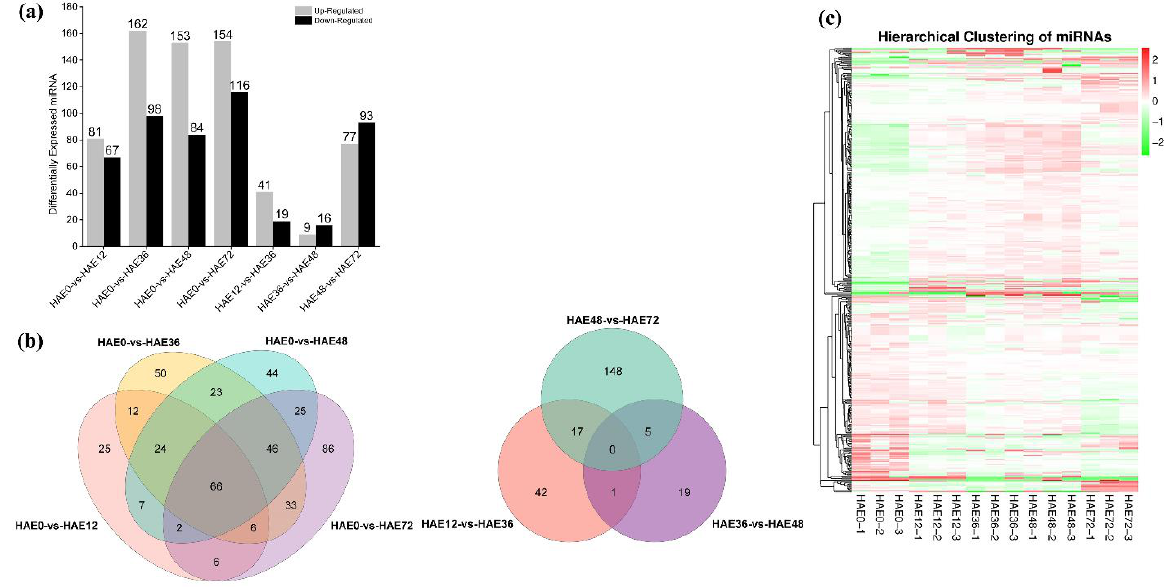
Figure 2. The number of differentially expressed (DE) microRNAs in dark-pretreated micro-shoot cuttings of tetraploid R. pseudoacacia L. during IBA-dependent AR formation in seven comparison group libraries (HAE0-vs-HAE12, HAE0-vs-HAE36, HAE0-vs-HAE48, HAE0-vs-HAE72, HAE12-vs-HAE36, HAE36-vs-HAE48, and HAE48-vs-HAE72). ( a ) Total upregulated and downregulated DE miRNAs expressed in seven comparison group libraries. ( b ) Venn diagrams showing the number of the differentially expressed miRNAs in the seven comparison group libraries. ( c ) Heatmap showing the fold changes of miRNAs in comparison group libraries.